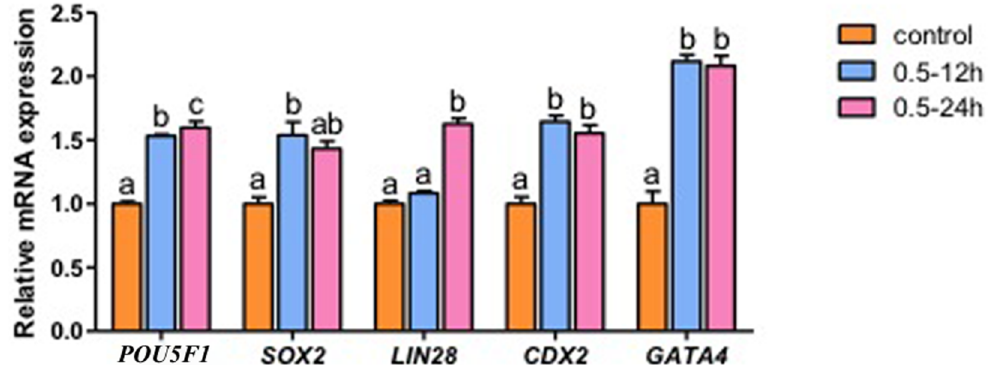
Fig 4. DOT1L inhibition enhances expression levels of genes important for pluripotency establishment and lineage specification. RelativemRNA levels of POU5F1 , LIN28 , SOX2 , CDX2 and GATA4 in SCNT blastocysts. Expression levels were determined by quantitative RT-PCR and were normalized against endogenoushousekeeping gene EF1 α 1 .Orange bars indicate SCNT control group, blue bars denoteSCNT embryos treated with 0.5 nM EPZ for 12 h and pink bars representSCNT embryos treated with 0.5 nM EPZ for 24 h. Data are shown as mean ± S.E.M. Values with different superscripts across groupsindicate significant differences( p <